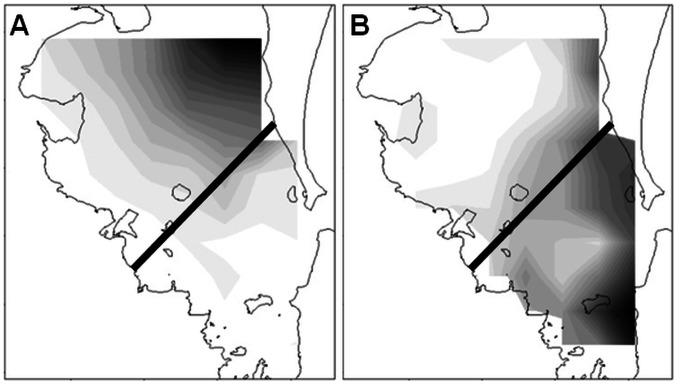
Assignment of individual bottlenose dolphins to sub-populations based on sighting density.Maps of sighting density of bottlenose dolphin sub-populations, A) North and B) South, in Moreton Bay, as predicted by generalised linear modelling (see Ansmann 2011). Individuals that could not be assigned genetically were assigned based on whether their mean sighting location fell north or south of the black diagonal line.